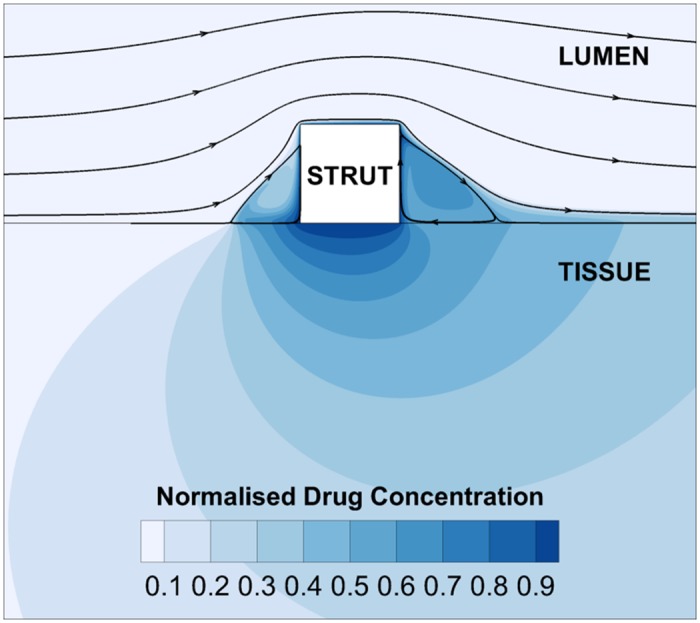
Drug concentration distribution and flow pathlines in the stented artery.